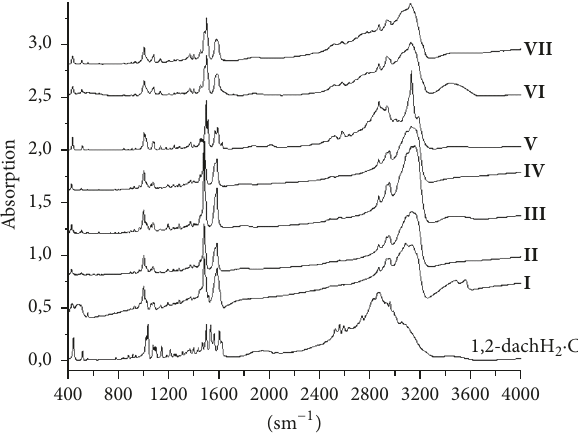
Figure 3: IR spectra of phases (I) – (VII) and 1,2-dachH 2 Cl 2 .